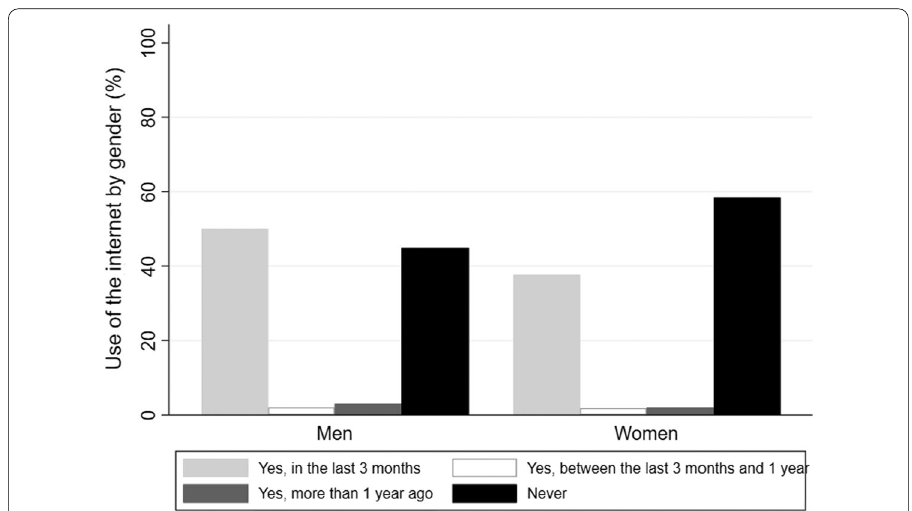
Fig. 1 Use of the Internet by gender (Source: Aspects of Daily Life (AVQ), 2016)